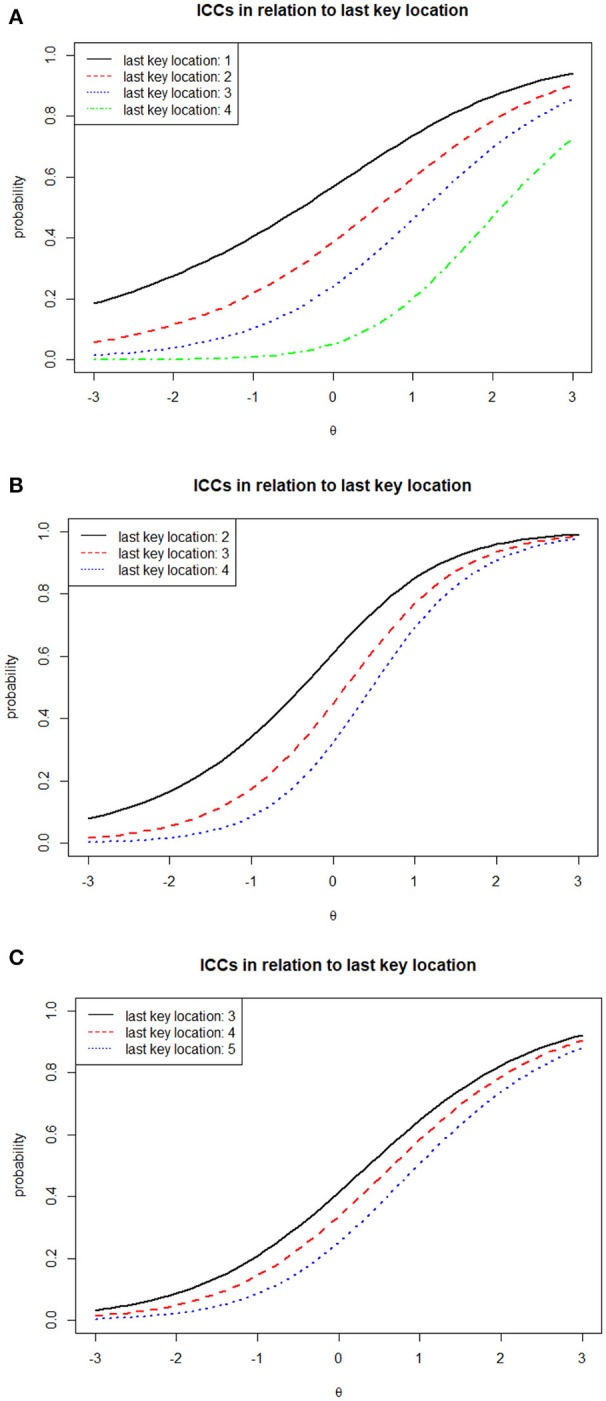
Estimated item characteristic curves (ICCs) for three DOMC items, IT Certification Test (N = 648). (A) Single-Keyed Item (1–4 Possible Response Options); Item 18 (a = 0.953, b = 1.007, ξ1 = 0.441, ξ2 = 0.742, ξ3 = 1.107, ξ4 = 2.303). (B) Double-Keyed Item (2–4 Possible Response Options); Item 30 (a = 1.461, b = 0.307, ξ1 = 0.526, ξ2 = 0.850, ξ3 = 1.198). (C) Triple-Keyed Item (3–5 Possible Response Options); Item 27 (a = 0.913, b = 0.123, ξ1 = 1.176, ξ2 = 1.450; ξ3 = 1.833).